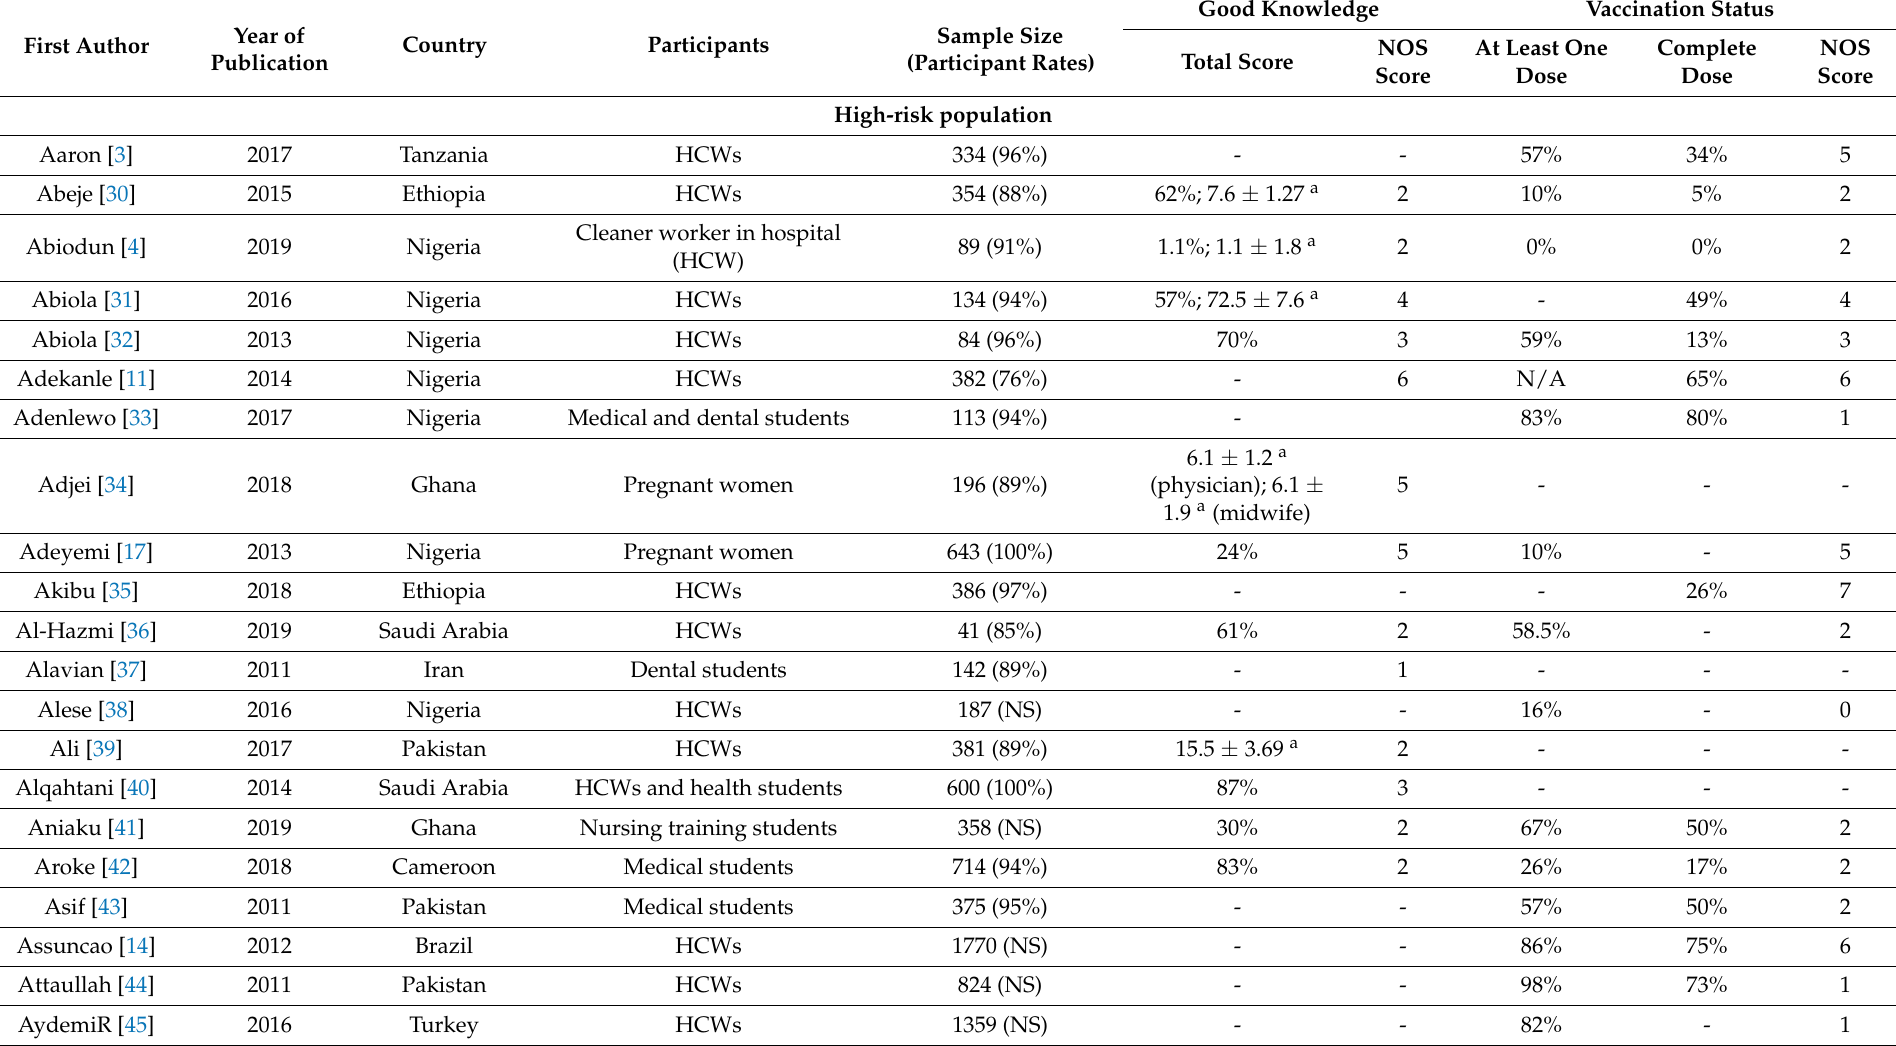
Table 2. Overview of hepatitis B knowledge and vaccination